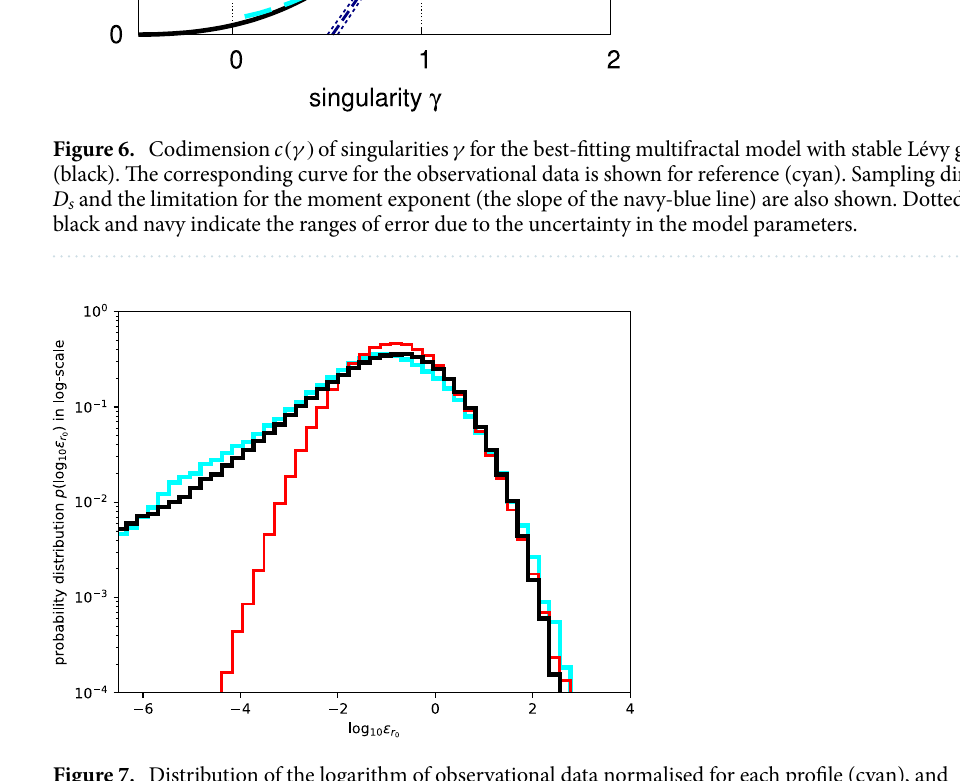
Figure 7. Distribution of the logarithm of observational data normalised for each profile (cyan), and comparison with the statistics of samples generated from multiplicative cascade with Gaussian/stable Lévy generators